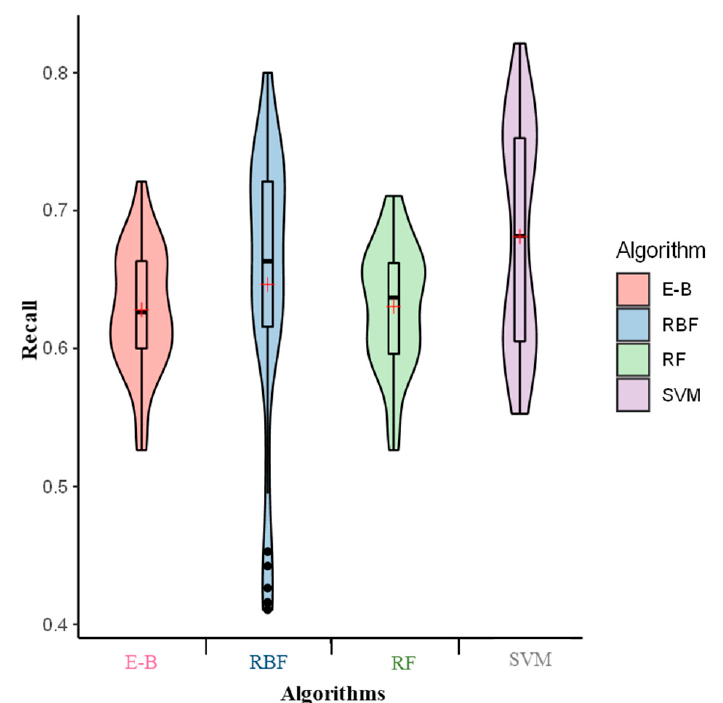
Figure 2. Recall of the radial basis function (RBF), support vector machine (SVM), random forest (RF), and ensemble-bagging (E-B) algorithms for off-target activity prediction using MIT and CDF scores. × indicates the mean performance of recall.